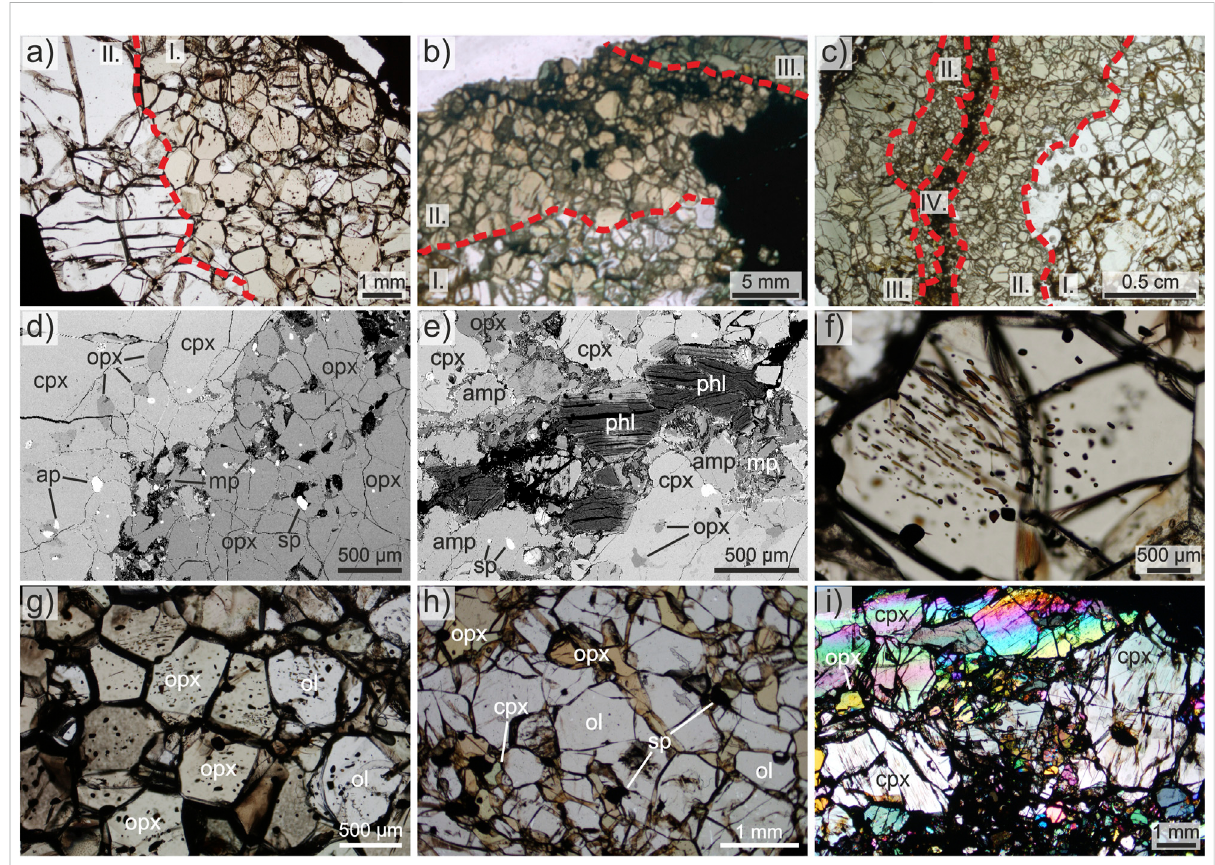
FIGURE 3 Photomicrographs of upper mantle xenoliths from Mindszentkálla (Bakony-Balaton Highland Volcanic Field) showing different textural characteristics. (A) Composite xenolith with olivine-orthopyroxenite (I) and dunite (II) domains (transmitted, plane-polarized light) (MSZK1301D). (B) Compositexenolithwithharzburgite (I) ,orthopyroxenite (II) andwebsterite (III) domains(scannedimage)(MSZK1306B). (C) Compositexenolithwith harzburgite (I) ,orthopyroxenite (II) websterite (III) andamphibole-phlogopitevein (IV) domains(scannedimage)(MSZK1305). (D) Contactzone between orthopyroxenite (right side) and websterite domains (left side) with resorbed orthopyroxenes in the former in a composite xenolith (backscattered electron image) (MSZK1306B). (E) Detailed image of the amphibole-phlogopite vein (backscattered electron image) (MSZK1305). (F) Numerous spinel inclusions hosted in orthopyroxene in a harzburgite (transmitted, plane-polarized light) (MSZK0701). (G) Equigranular textured harzburgite (transmitted, plane-polarized light) (MSZK1302). (H) Coarse granular textured harzburgite (transmitted, plane-polarized light) (MSZK1301B). (I) Magmatic textured websterite in the upper part of the photo (transmitted, cross-polarized light) (MSZK1305).